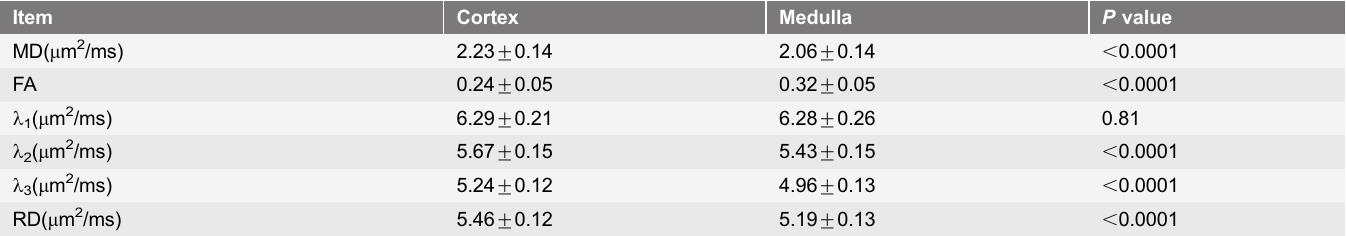
Table 2. DTI parameters in the cortex and